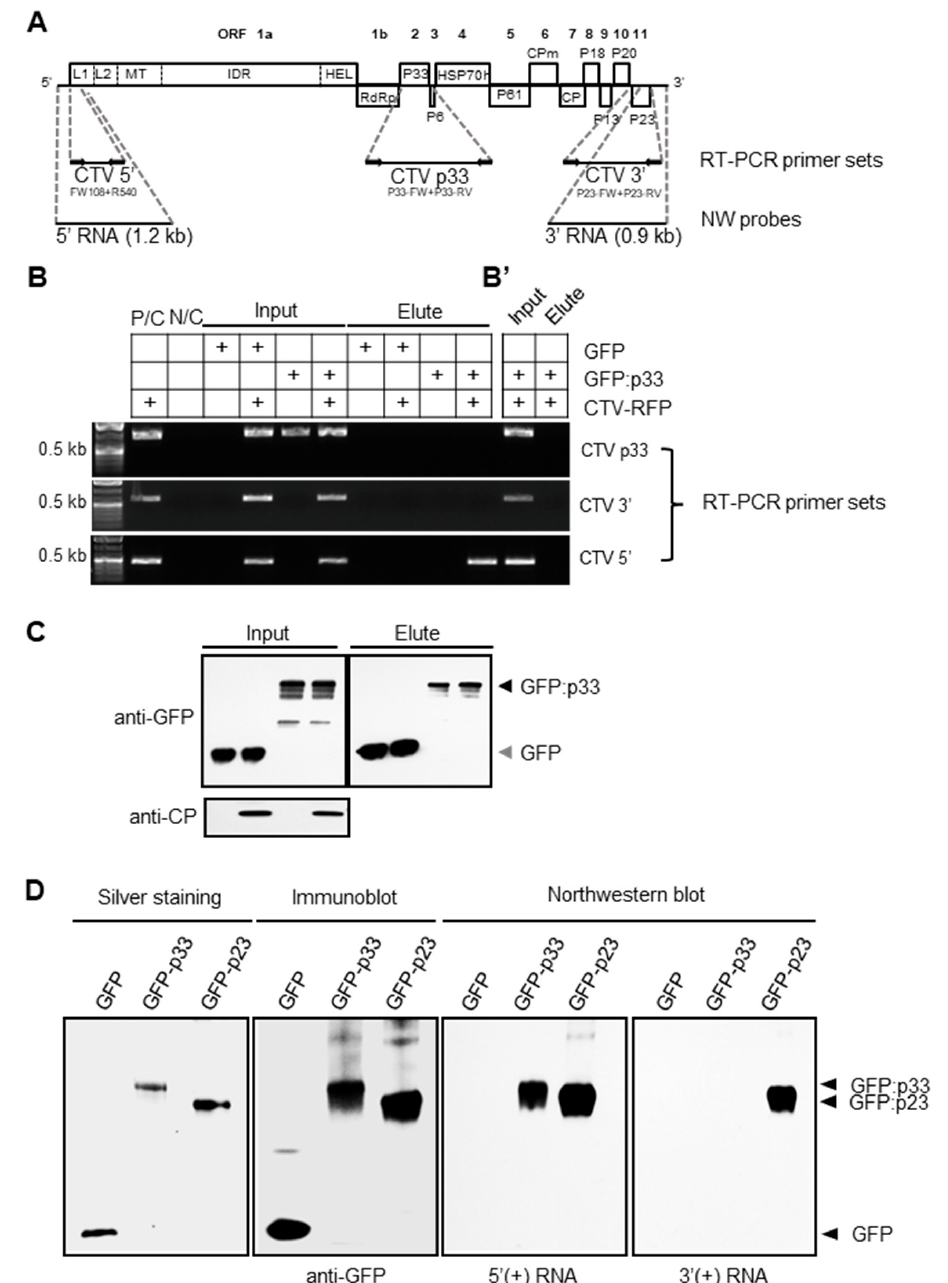
Figure 1. RNA-binding property of the p33 protein. ( A ) Schematic representation of the CTV genome and the regions targeted for the amplification and probe hybridization of RNA bound to the protein trapped via anti-GFP antibody-conjugated agarose beads in the RIP assay. The boxes represent ORFs and their translated products. L1 and L2, papain-like leader proteases; MT, methyltransferase; IDR, large interdomain region; HEL, helicase; RdRp, RNA-dependent RNA polymerase; CPm, minor coat protein; HSP70h, heat shock protein 70 homolog; CP, coat protein. Sequences of primers can be found in Supplementary Table S1. ( B ) RT-PCR analysis of the RNA extracted at two steps (“Input” and “Elute”) of the RIP assay. Input:—the supernatant of the leaf homogenate in the lysis buffer after centrifugation at 3000× g ; Elute:—beads left at the final step of